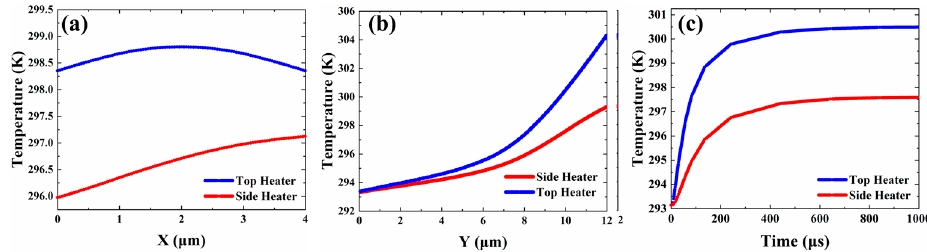
Figure 7. The temperature of the VOA when using different heaters. ( a ) The temperature change in the X direction. ( b ) The temperature change in the Y direction. ( c ) The change of waveguide’s average temperature under pulsed voltage.